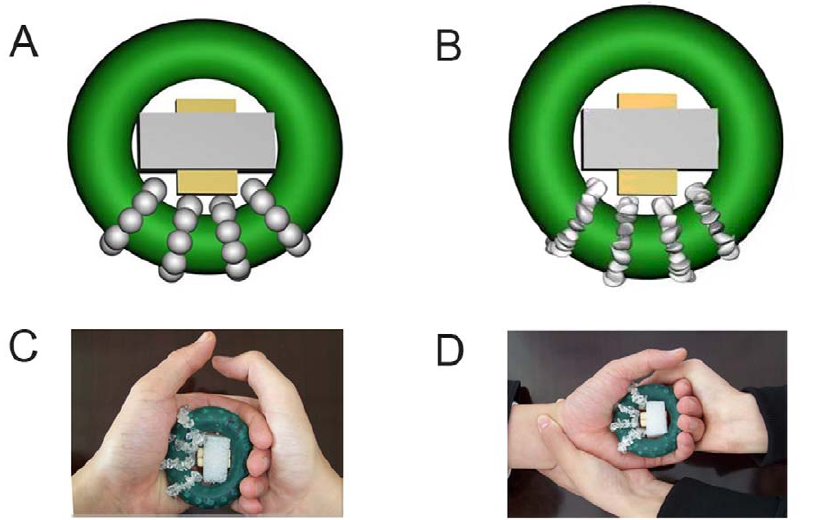
Figure 5. Schematic diagram of the pressure and pain stimuli and experimental conditions. (A) Pressure ring with spherical beads. (B) Pain ring with polyhedral beads. (C) Self-induced movement, in which the subject squeezes his own left hand with his right hand; the pain ring is pictured. (D) Externally induced movement, in which the experimenter squeezes the subject’s left hand; the pain ring is pictured. Within the rubber ring was the cross holder, consisted of the yellow short arms and the grey long